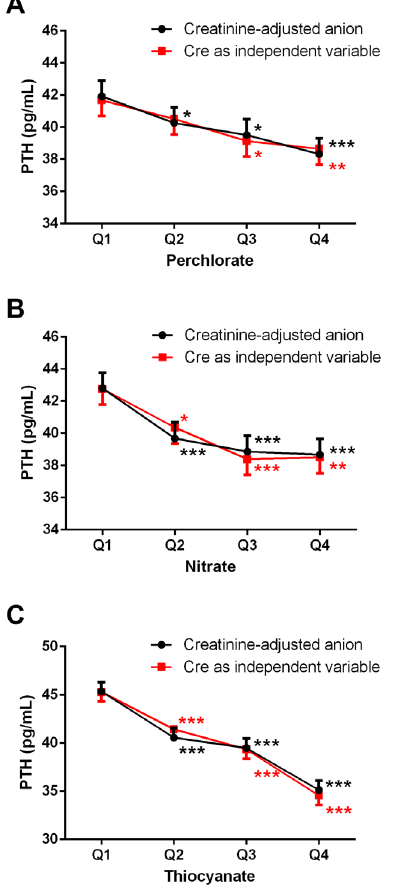
Fig. 1. Weighted mean ¡ SE of serum parathyroid hormone (PTH) levels versus urinary concentrations of perchlorate, nitrate, and thiocyanate among the United States adults, NHANES 2005–2006. Analyses were performed with two approaches: (1) creatinine-corrected urinary measurements, and (2) analyte concentration unadjusted for creatinine but urinary creatinine was included as a separate independent variable. A , Serum PTH levels by urinary perchlorate quartiles. B , Serum PTH levels by urinary nitrate quartiles. C , Serum PTH levels by urinary thiocyanate quartiles. Adjusted for age, race/ethnicity, smoking status, body mass index, corrected total serum calcium, and 25-hydroxyvitamin D levels. * P , 0.05, ** P , 0.01, *** P , 0.001 versus first